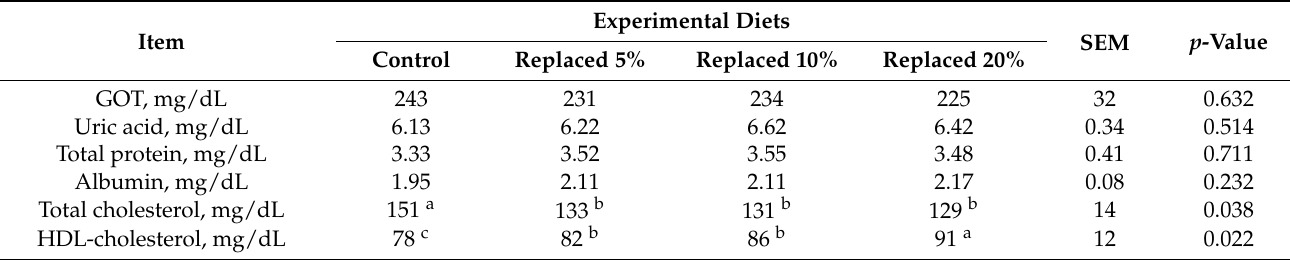
Table 4. The effects of replacing corn with olive cake meal (OCM) on plasma parameters in